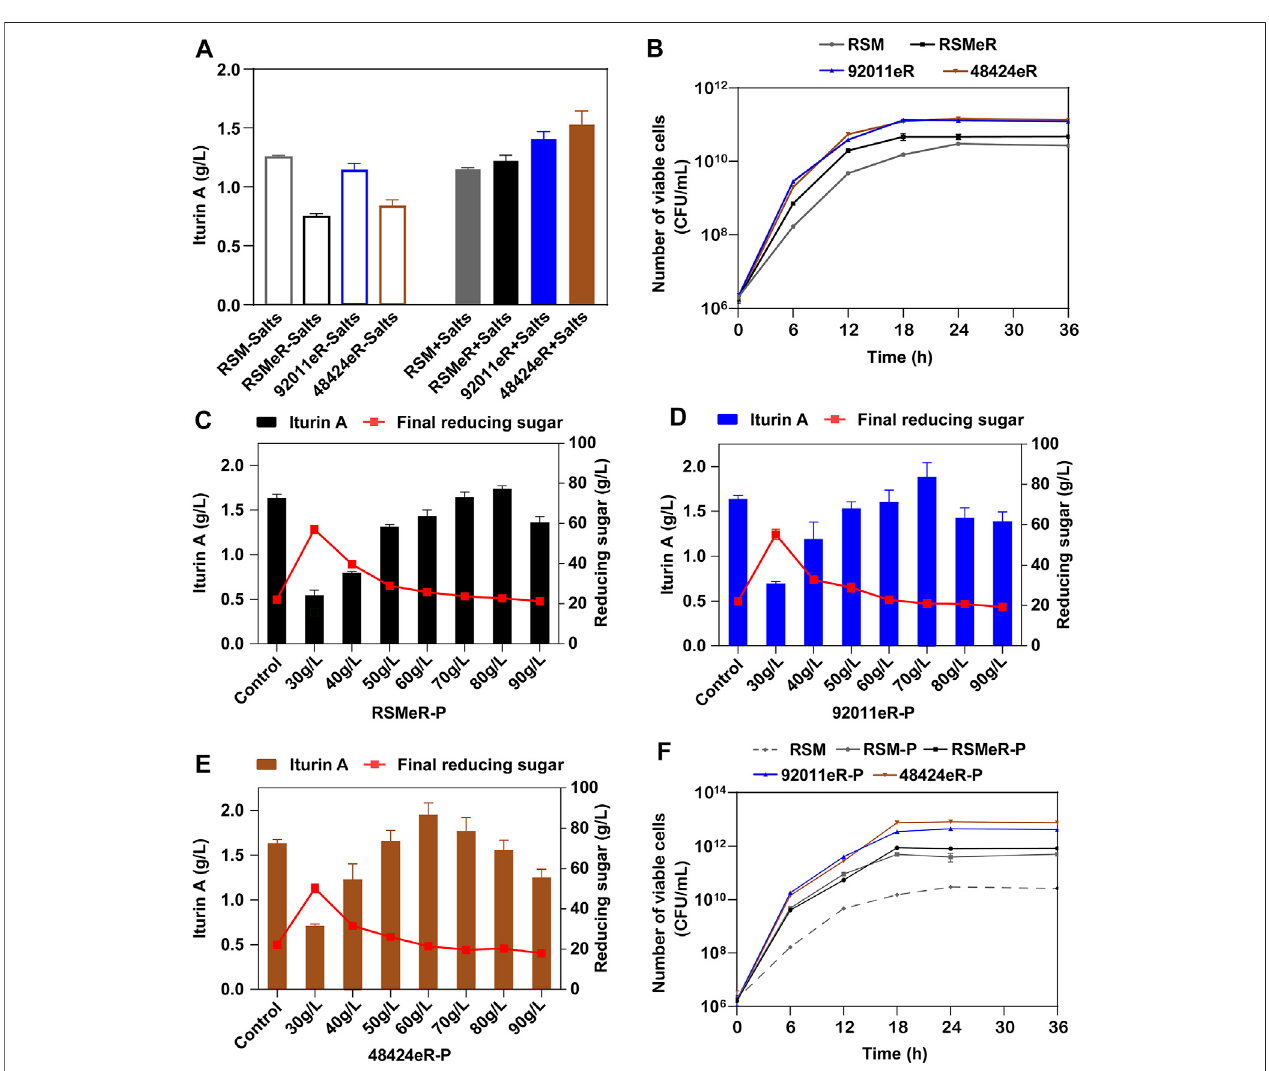
FIGURE 5 | Effects of two-step strategy on residue ’ s value for iturin A production (A) and the growth of B. amyloliquefaciens CX-20 (B) . -Salts means that not any inorganic salts is added into the medium, while + Salts means that inorganic salts is added into the medium. Effects of different initial concentrations of RSMeR-P (C) , 92011eR-P (D) and 48424eR-P (E) on iturin A production and fi nal concentration of reducing sugar. (F) The effect of optimal concentration of RSM, RSM-P, RSMeR-P, 92011eR-P and 48424eR-P on the growth of B. amyloliquefaciens CX-20.